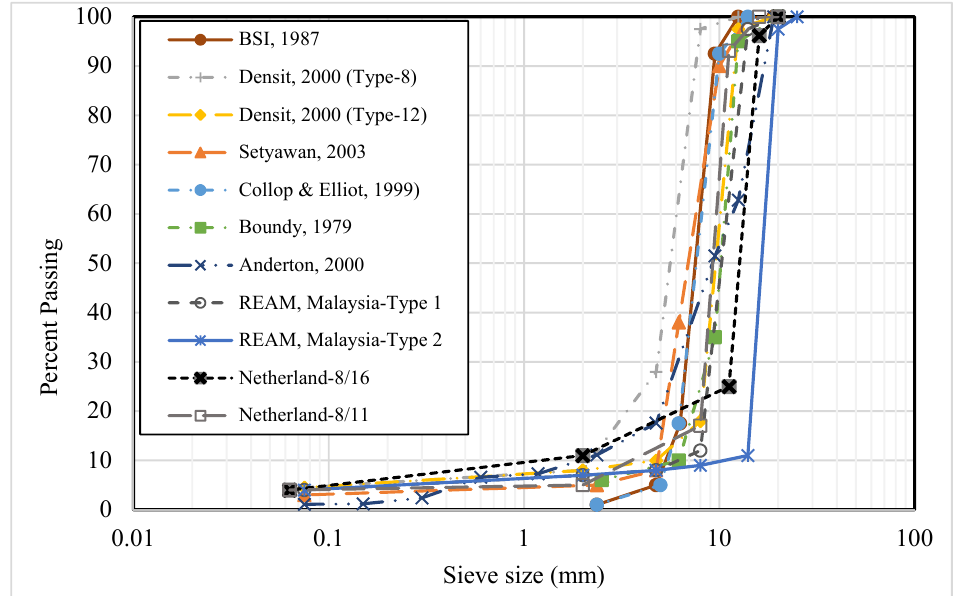
Figure 2. Porous aggregate gradation used in past studies.